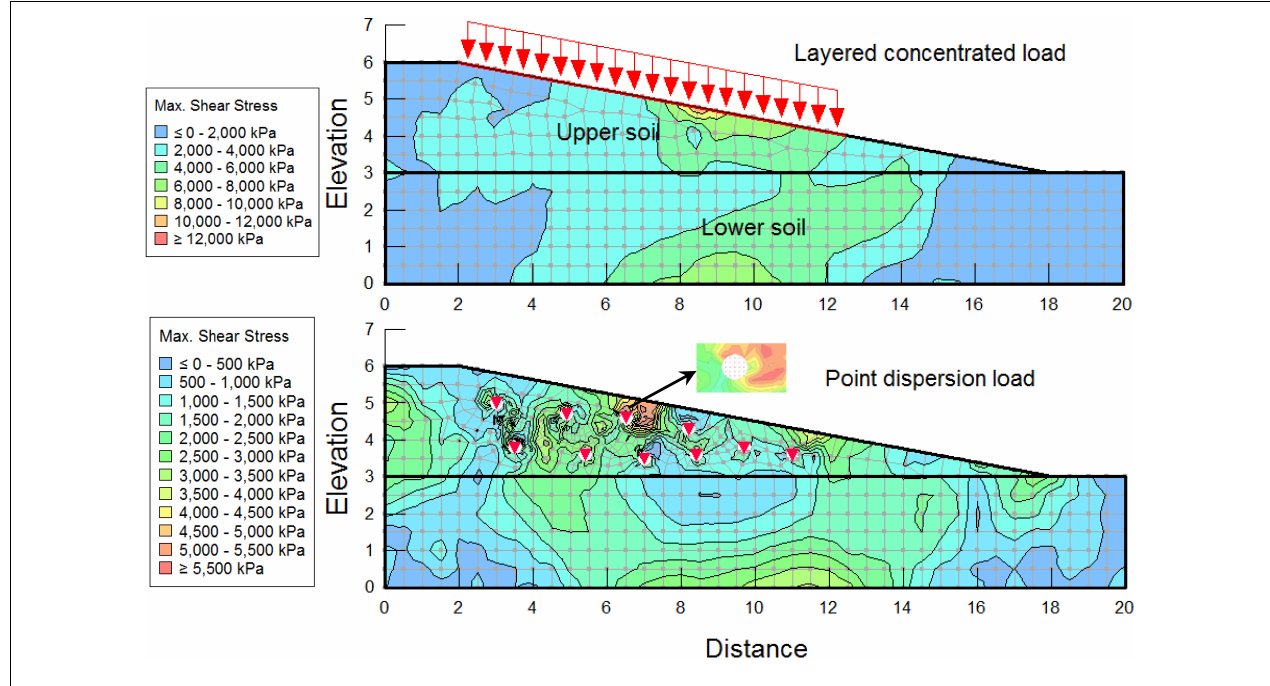
FIGURE 7 | Stress redistribution caused by layered concentrated load and point load.